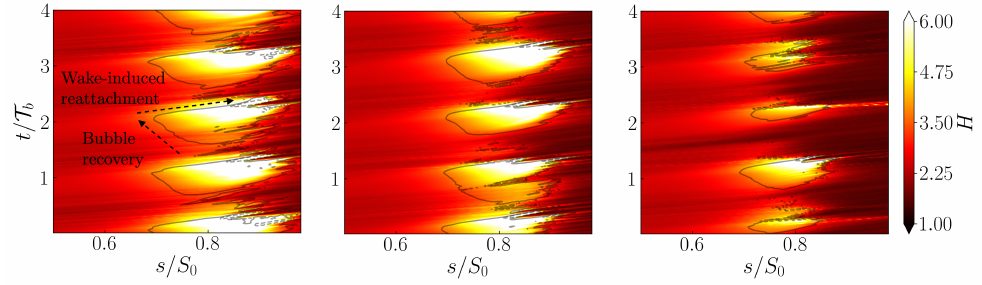
Figure 5. Instantaneous space–time contour of suction surface BL shape factor, superimposed with iso-lines of wall-shear stress at two levels: C f = 0 (continuous line), C f = ( Left ): Re 2 = 86,000; ( middle ): Re 2 = 157,000; ( right ): Re 2 =